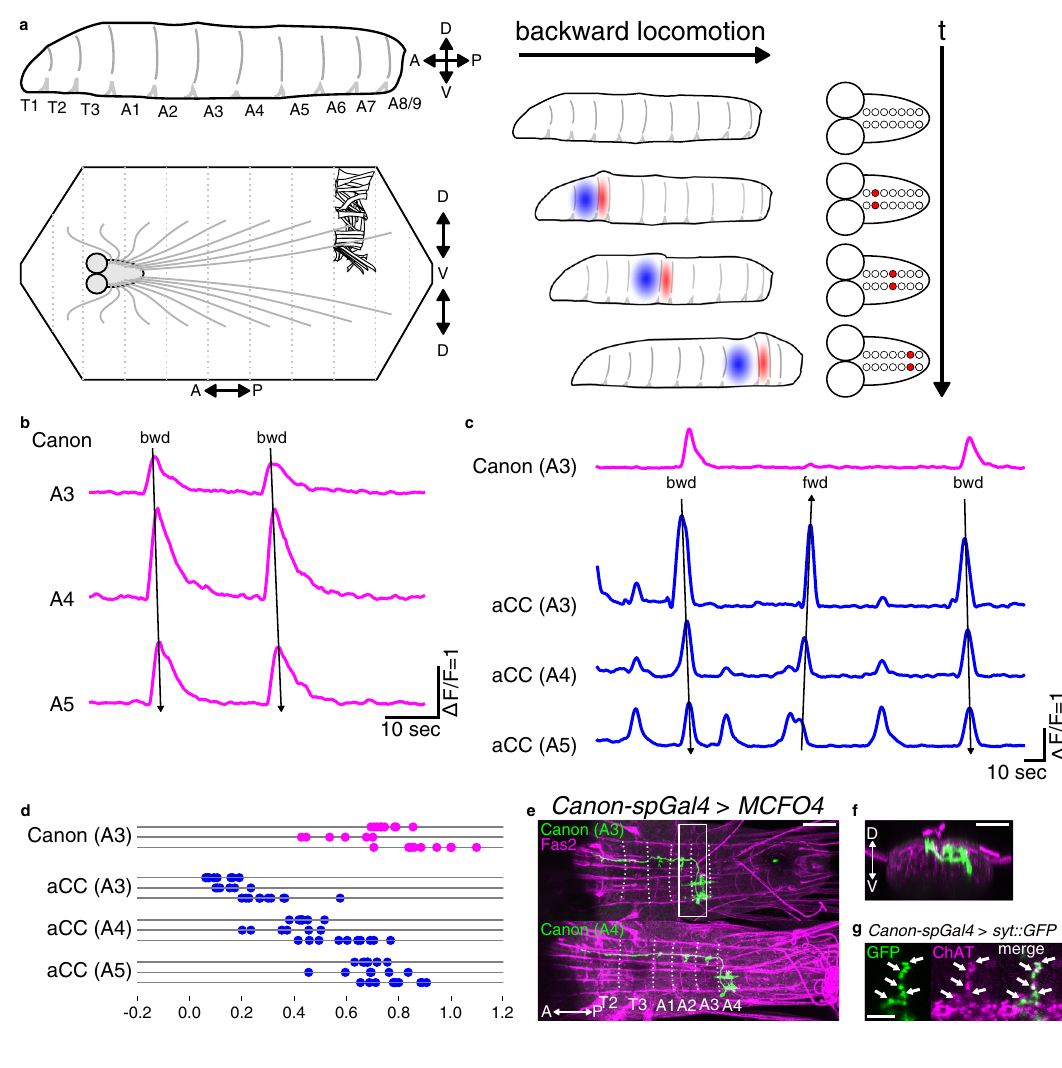
Fig. 1 Activity and anatomy of Canon neurons. a (Left) A scheme of a larval body which is segmented into T1 – 3 and A1 – 9 (top). A scheme of a dissected larva, body-wall muscles, and the CNS (bottom). A CNS is also segmented and MNs on located in each neuromere sends outputs to muscles located on corresponding segment. (Right) Larval peristaltic behavior is generated by the propagation of muscular contraction (red) and delayed relaxation (blue) (left), which are induced by propagation of activity of MNs (red) (right). b Canon neurons in A3 – A5 neuromeres show propagating activity in the backward direction. c Simultaneous imaging of A3 Canon neuron (magenta) and A3 – A5 aCC MNs (blue). Backward (bwd) and forward (fwd) fi ctive waves are indicated by arrows in b , c . d Linear phase plot of activity peaks in an A3 Canon neuron (magenta) and A3 – A5 aCC MNs (blue) during backward waves. Each of the three horizontal lines represents an individual preparation. The timings of the activity peaks in each neuron relative to the phase of backward peristalses were plotted. Phase 0 is initiation of activity of A2 Canon neuron, while Phase 1 is peak of activity of A6 Canon neuron. n = 26 waves from three larvae. e , f Morphology of single-cell clones of Canon neurons in A3 (top) and in A4 (bottom) obtained by MCFO. Dotted lines indicate segmental borders identi fi ed by the Fasciclin2 (Fas2)-positive TP1 tract 47 . e Dorsal view, f anterior view reconstructed from the region shown by a white box in e . The images are representative data from one of 12 independent experiments that gave similar results. g A focal plane showing that presynaptic sites of Canon neurons visualized by the expression of a presynaptic marker Syt-GFP (green) are also positive for ChAT (magenta, arrows). The image is a representative datum of one experiment. Scale bars, 50 μ m ( e , f ) and 5 μ m ( g